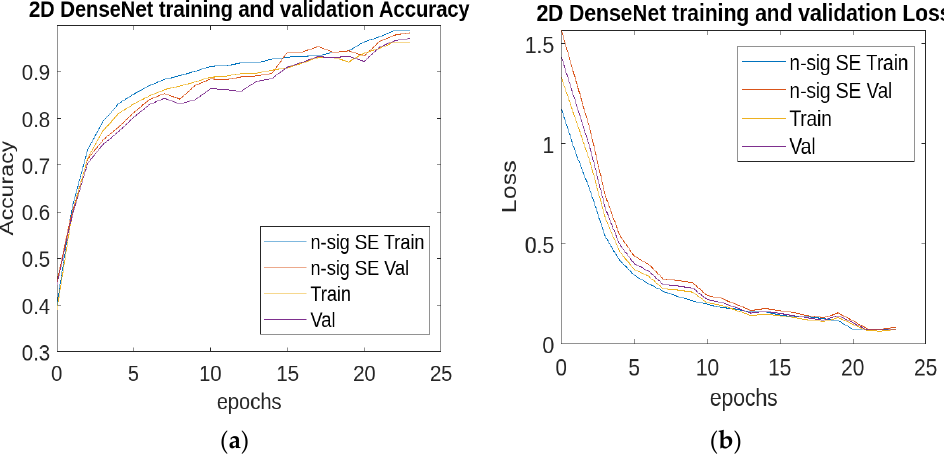
Figure 11. ( a ) Training and ( b ) validation accuracy and loss curves of the SE DenseNet and the n-sigmoid SE DenseNet.